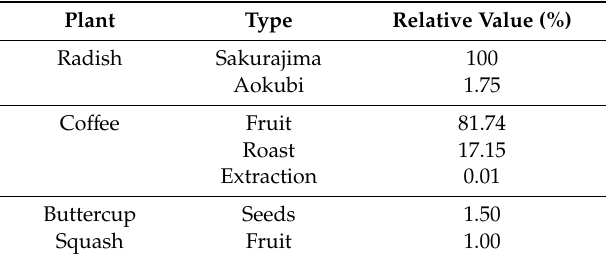
Table 1. Comparison of trigonelline amounts in di ff erent